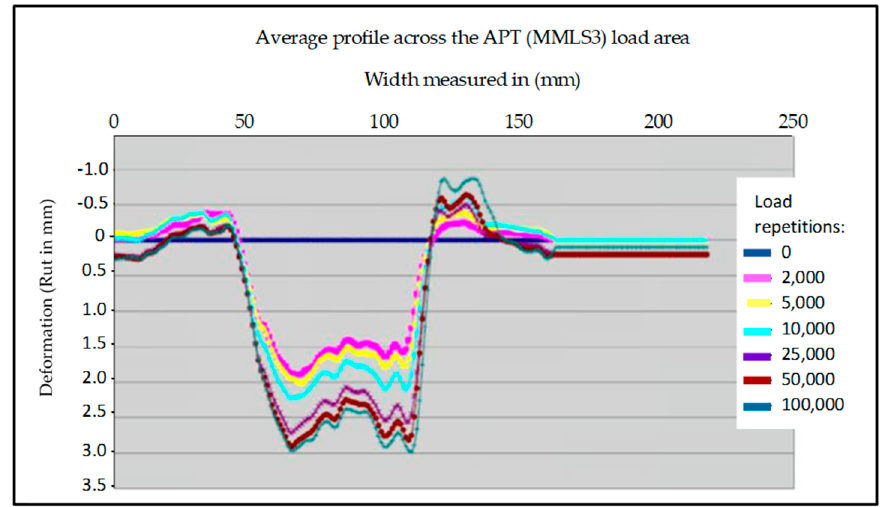
Figure 16. Average of the profile measurements taken at various repetitions during the full MMLS3 test (APT) done on the Cape seal.